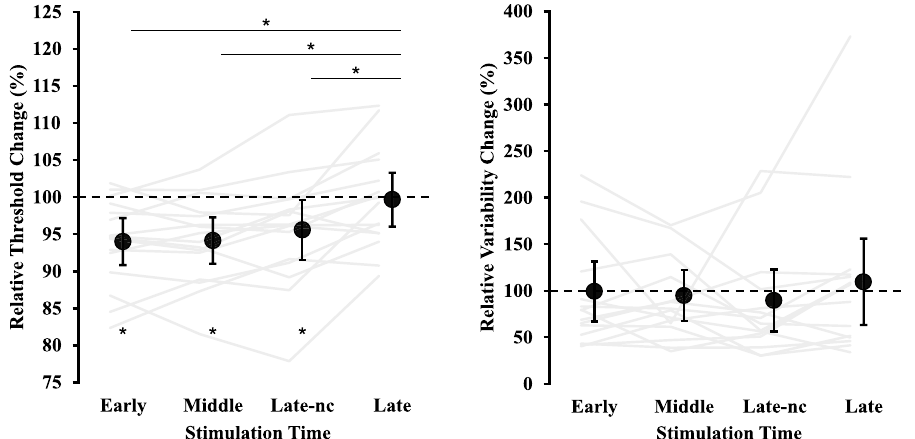
Figure 2. Left Panel: The statistically significant main effect of Stimulation Time ( p < 0.01) for the relative threshold change, based on the Pre object movement condition. The stars on the bottom half of the graph represent a statistically significant difference from 100% at the Early, Middle and Late-nc stimulation times (all p ’s < 0.03). The stars on the top half of the graph represent a statistically significant relative threshold change between the Late stimulation time and all other stimulation times (all p ’s < 0.01). Right Panel: The relative variability change across Stimulation Time conditions ( p = 0.52). Note that the detection variability difference was also relative to the Pre object movement condition. For both panels, grey lines represent individual participants, black dots represent mean values, and error bars represent 95%